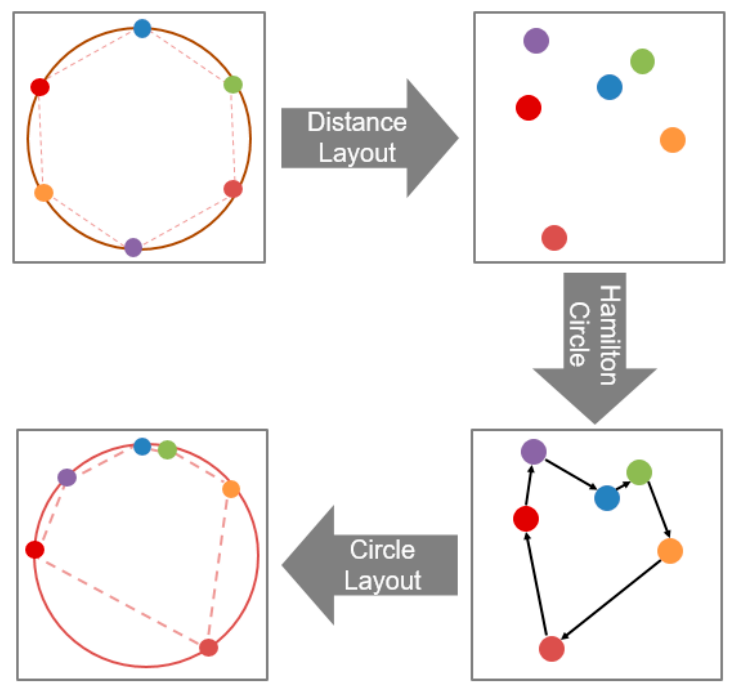
Figure 4. Illustration of the distance spaced attribute layout scheme.